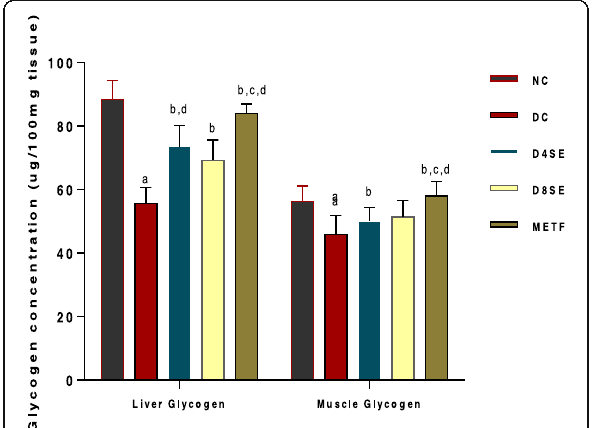
Fig. 4 Effects of SE and METF on liver and muscle Glycogen concentration in STZ-Treated rats. Values are expressed as mean±SEM of 8 rats. NC= Normal control, DC=Diabetic control, D4SE=Diabetic animals treated with SE (400 mg\kg BW), D8SE=Diabetic animals treated with SE (800 mg\kg BW), DMETF=Diabetic animals treated with metformin (12 mg\kg BW). a =significant when compared to NC, b=significant when compared to DC, c=significant when compared D4SE d=significant when compared to D8SE, f=significant when compared to DMETF